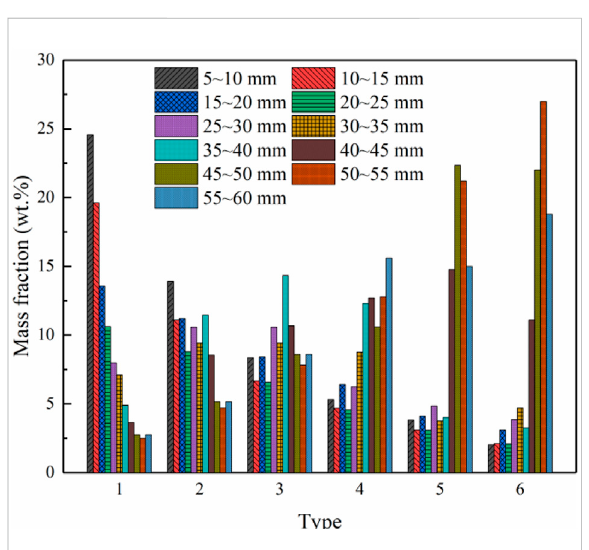
FIGURE 6 Mass fraction of each mono-size sinter in six types of the multi-size sinters.